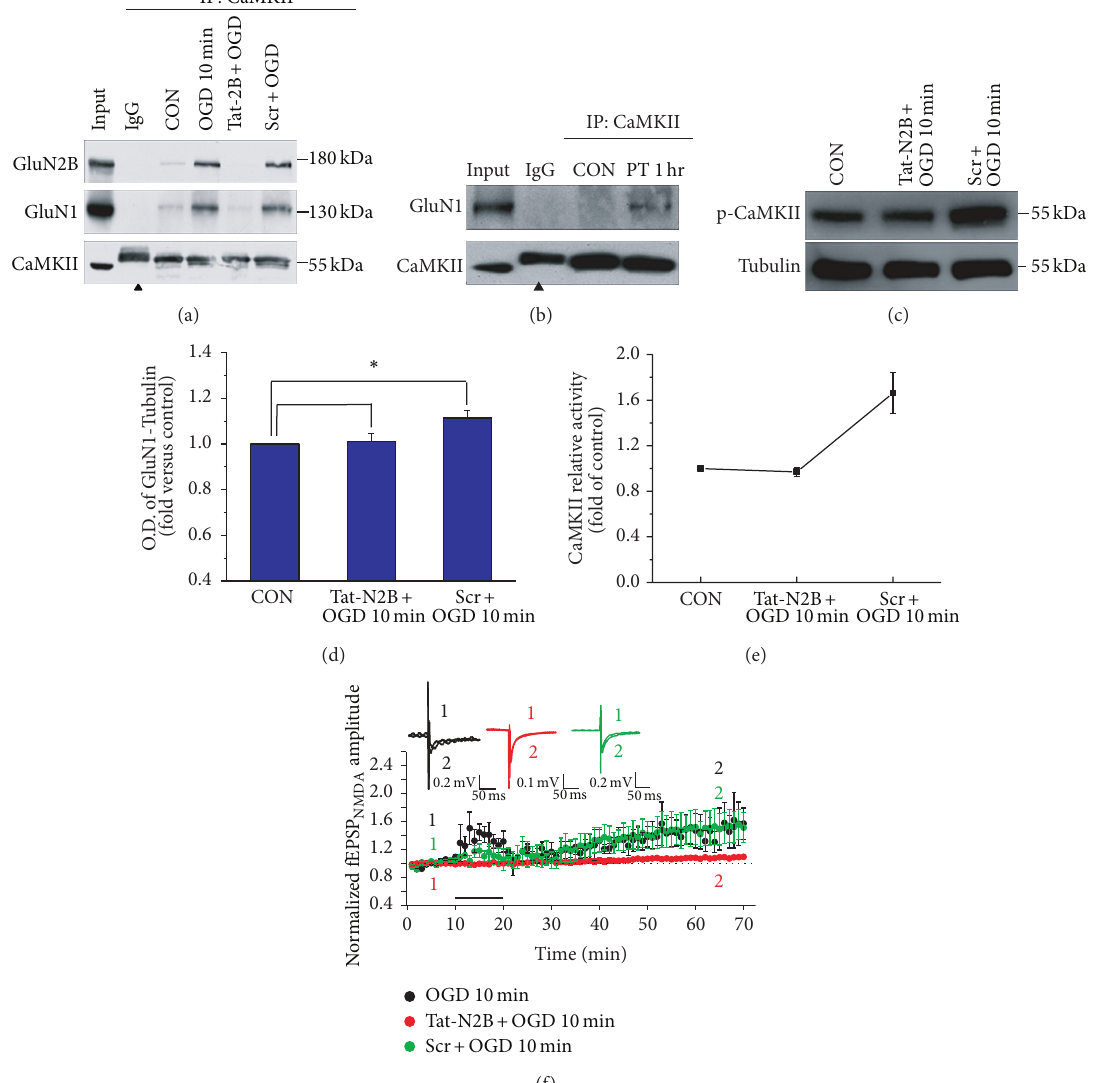
Figure 5: (a) Co-IP assay with anti-CaMKII antibody revealed the association of CaMKII and NMDAR. Peptides occluded the increase of CaMKII and NDMAR by OGD treatment while scramble peptides showed no effect. Arrowhead indicates the nonimmune IgG heavy chain. (b) Onehour after photothrombosis caused an increase in the interaction between CaMKII and NMDAR. Arrowhead indicates the nonimmune IgG heavy chain. ((c)-(d)) Peptides Tat-GluN2B suppressed the autophosphorylation of CaMKII in OGD model, compared with control, 1.01 ± 0.04 , 𝑛 = 4 , 𝑃 > 0.05 , while scramble peptides failed to exert any effect on OGD model, compared with control, 1.11 ± 0.03 , 𝑛 = 4 , ∗ 𝑃 < 0.05 . (e) Peptides Tat-GluN2B decreased the CaMKII relative activity when 10 min OGD was applied, compared with control, 0.97±0.04 , 𝑛 = 4 , 𝑃 > 0.05 , while scramble peptides failed to exert any effect when 10min OGD was used, compared with control, 1.66±0.18 , 𝑛 = 4 , ∗ 𝑃 < 0.05 . (f) Peptides Tat-GluN2B led to impaired i-LTP when the hippocampal slice was exposed to OGD for 10min, 𝑛 = 5 , compared with OGD, 𝑛 = 3 , 0.73±0.02 , 𝑃 < 0.05 . Scramble peptides were used when the hippocampal slice was exposed to OGD for 10min, 𝑛 = 5 , compared with OGD, 1.02 ± 0.03 , 𝑃 > 0.05 . As a control, OGD treatment for 10min exhibited normal i-LTP. Overlaid traces above the graph showed changes in amplitude of fEPSPs chosen at the times indicated on the